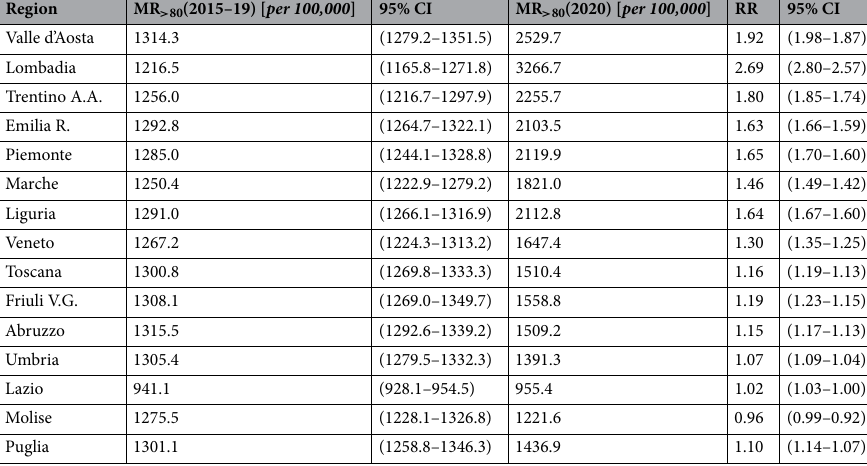
Table 3. Mortality rate per 100,000 in over 80, by region in last five years (MR > 80 (2015–19); in 2020 (MR > 80 (2020); and Rate Ratio (RR) and 95% CI for the period 1st March to 15th